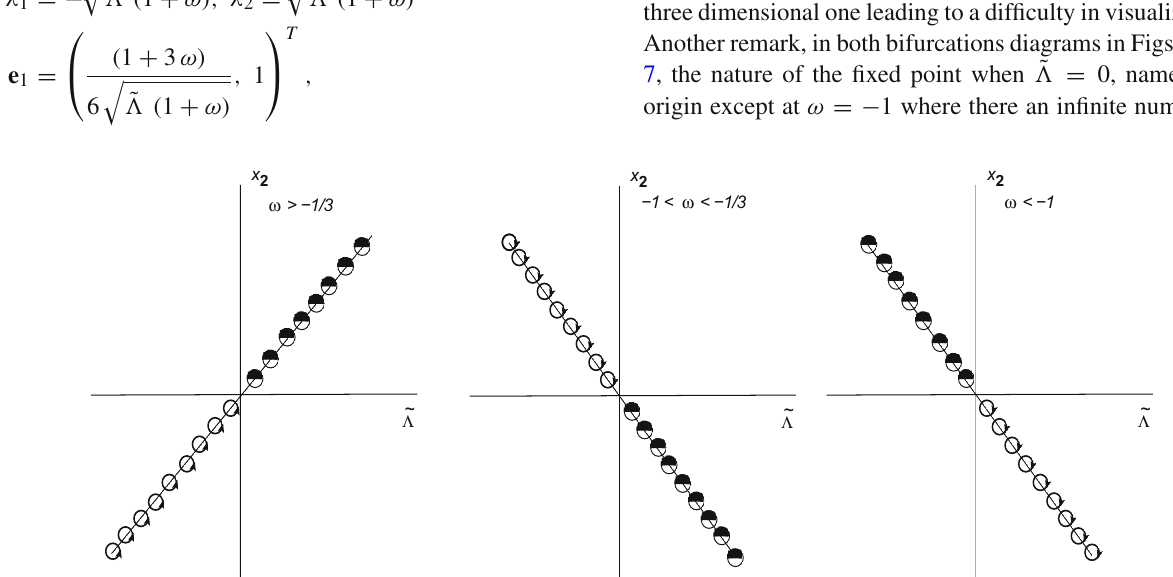
Fig. 7 The degenerate Hopf bifurcation diagram for all the three pos- sible regions of ω . the solid curve, x 2 = 2 points along the x 2 axis as a function of ˜ (cid:4) for a fixed value of ω in